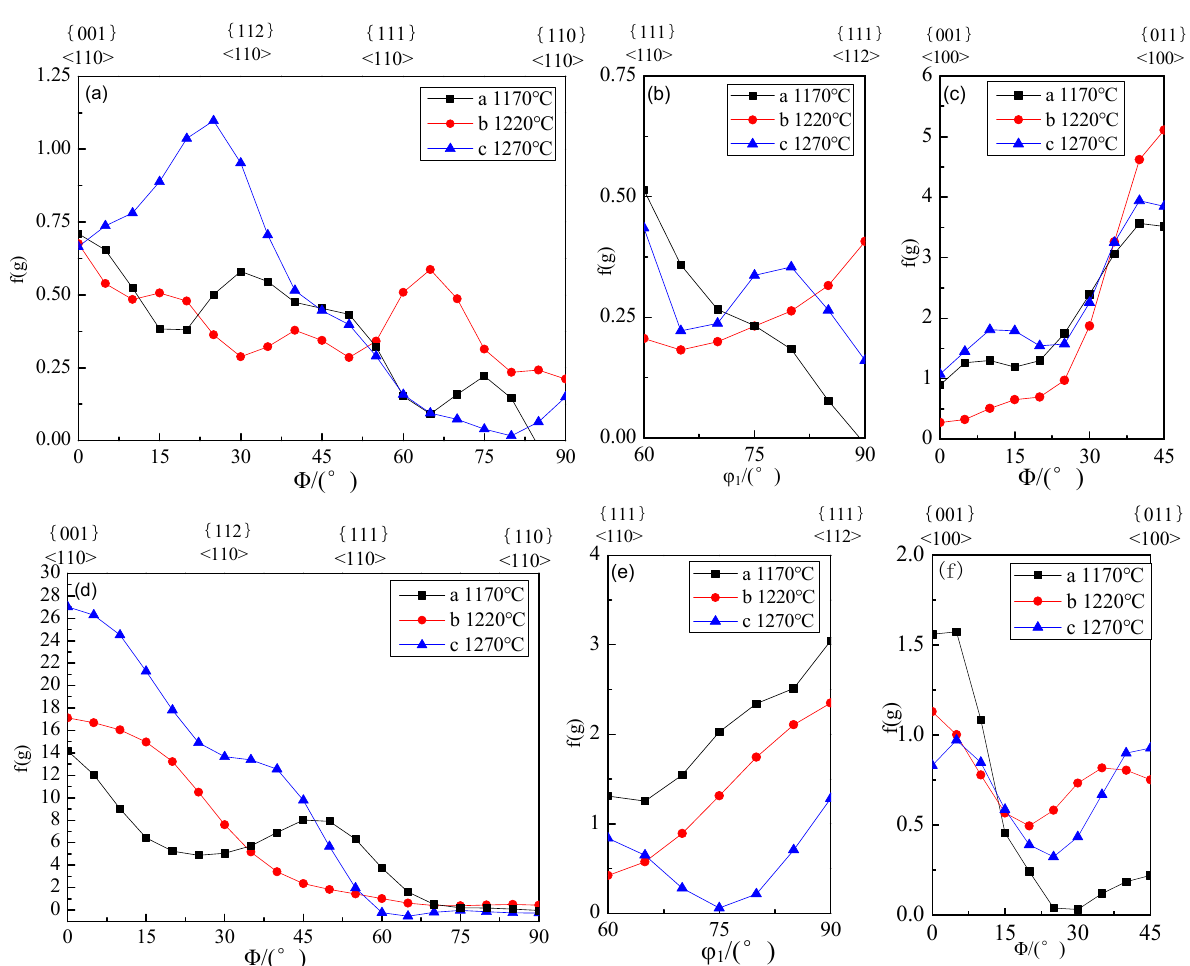
Figure 5. Orientation distribution intensities: Along ( a ) α‐ fiber, ( b ) γ‐ fiber, and ( c ) η‐ fiber after hot rolling with different slab heating temperatures; along ( d ) α‐ fiber, ( e ) γ‐ fiber, and ( f ) η‐ fiber after cold rolling with different slab heating temperatures.